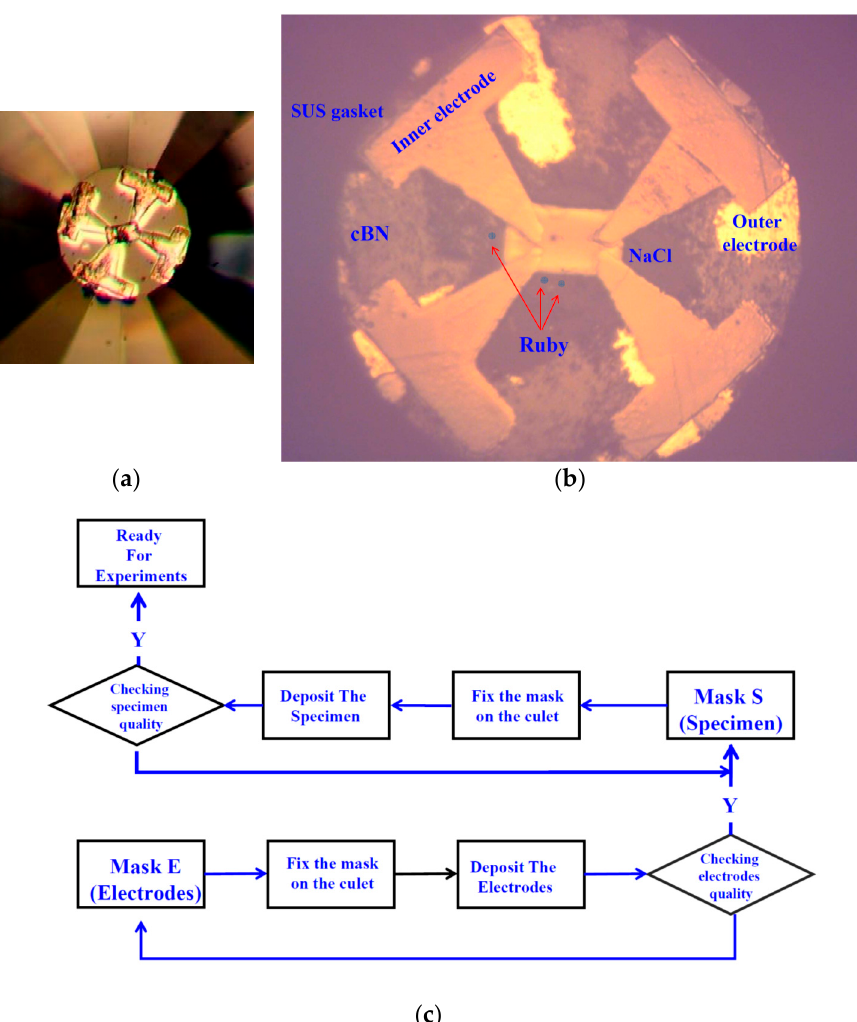
Figure 2. ( a ) The four deposited Pt electric probes that served as the inner electrodes on the culet of the diamond anvil (of 300 micrometer in size). ( b ) The La sample was further deposited above the Pt probes. The bright yellow electrodes are outer electrodes of the Au wire and the dim ones are inner electrodes, respectively. The locations of ruby balls are shown as solid circles. ( c ) The flow chart showing the primary procedure of ATHENA.